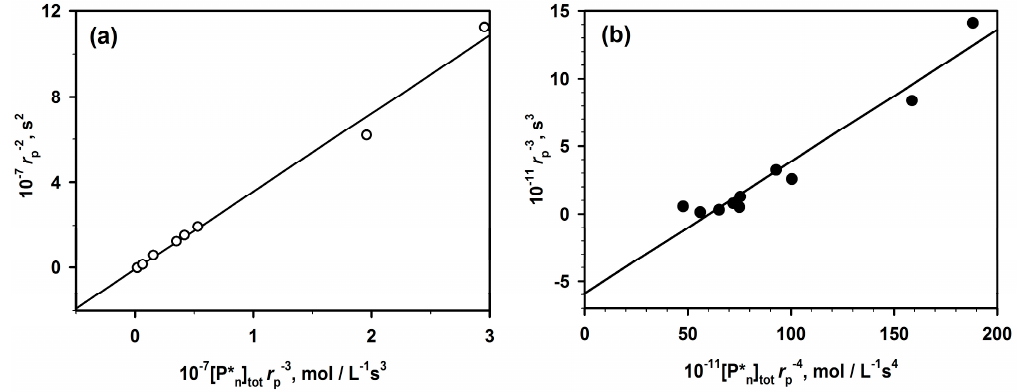
Figure 4. Polymerization of: oxirane ( a ); and hexamethylcyclotrisiloxane-D 3 ( b ). Conditions are in the description of Figure 3. Graphs have been taken, as above, from [8].